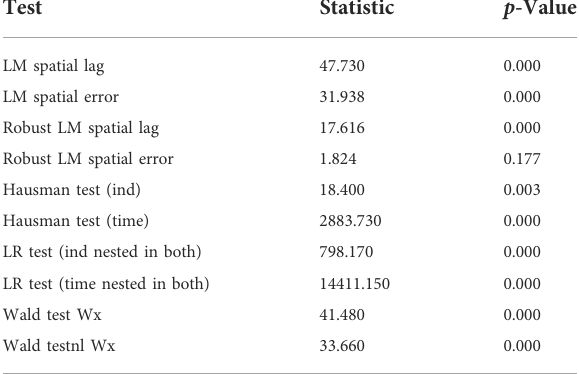
TABLE 4 Model test